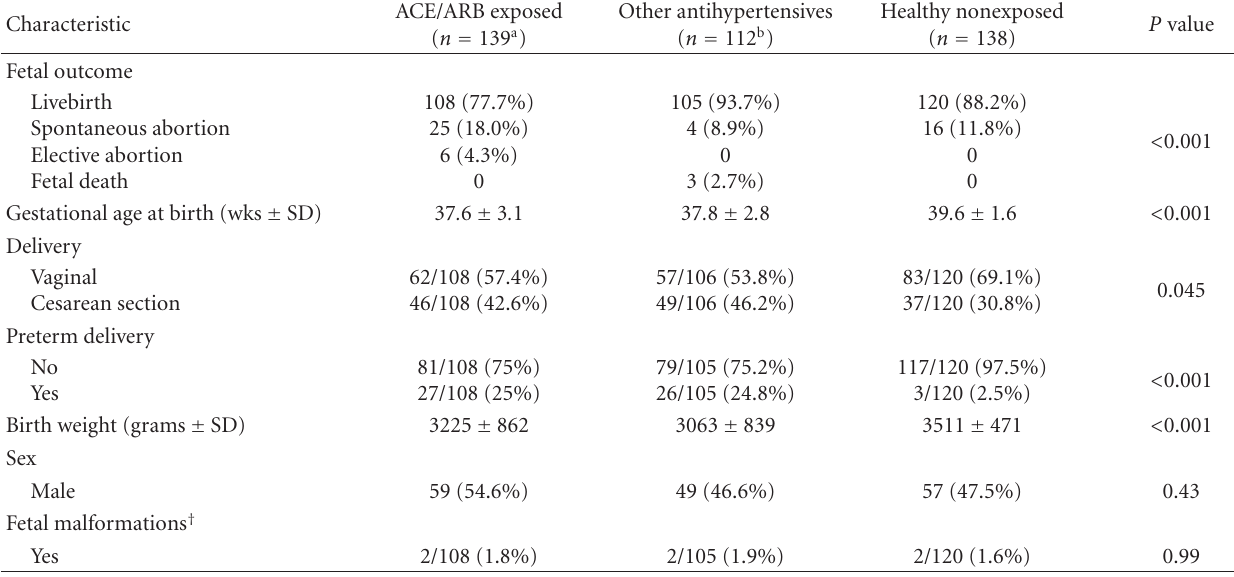
Table 3: Pregnancy outcomes following exposure to ACE/ARBs or other antihypertensives as compared to a healthy comparator group.